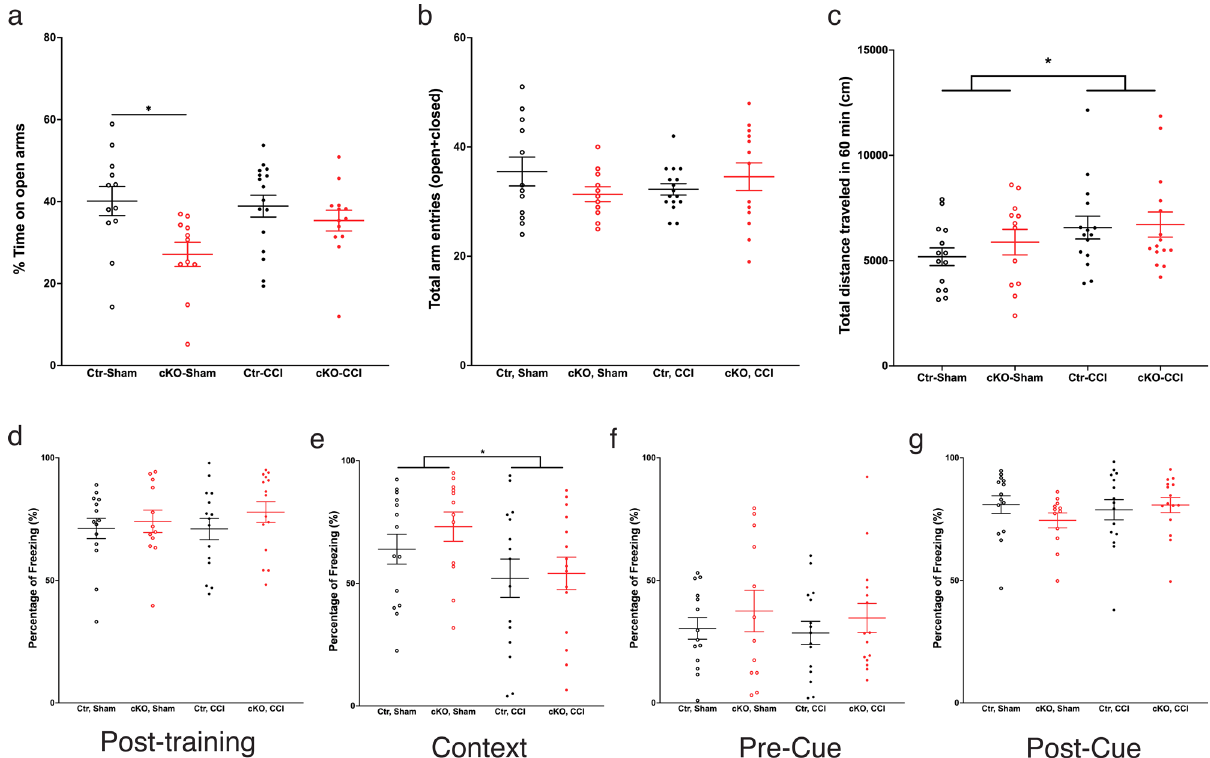
Fig. 8 Elevated plus maze, open fi eld, and fear conditioning. a , b In the elevated plus-maze task, the cKO-Sham mice spent signi fi cantly less time in the open arm compared with Ctr-Sham. No difference was observed between Ctr – CCI and cKO – CCI. For total entries of arms, no difference was observed among the four groups. c In the open- fi eld test, CCI mice traveled signi fi cantly longer distance compared with sham-operated mice, indicating CCI does not impair locomotor activity. d – g In the fear-conditioning test, no differences were observed during post-training, indicating similar responses to pain ( d ). In day 2 contextual memory test ( e ), CCI mice exhibited reduced % time freezing as compared with Sham groups. In the day-3 cued-memory test ( f , g ), no differences were observed among the four groups. Data are presented as means± SEM. *P <